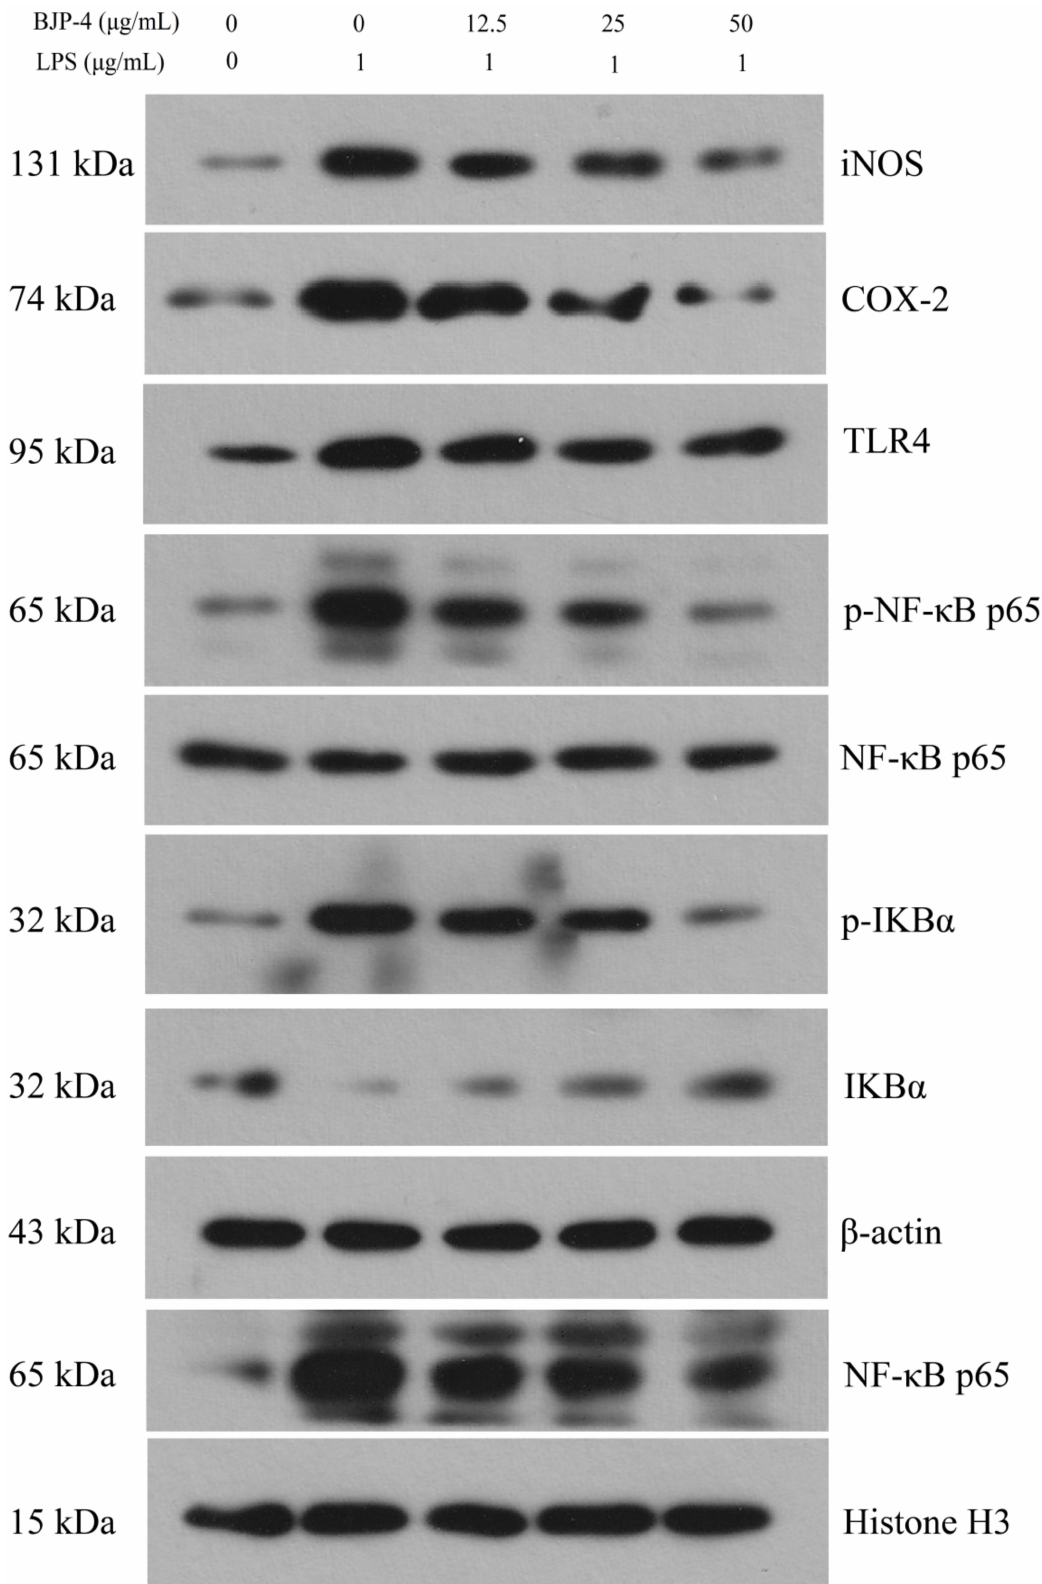
Figure 5. Western blot analysis of BJP-4 on the TLR4/NF- κ B signaling pathway in LPS-induced RAW264.7